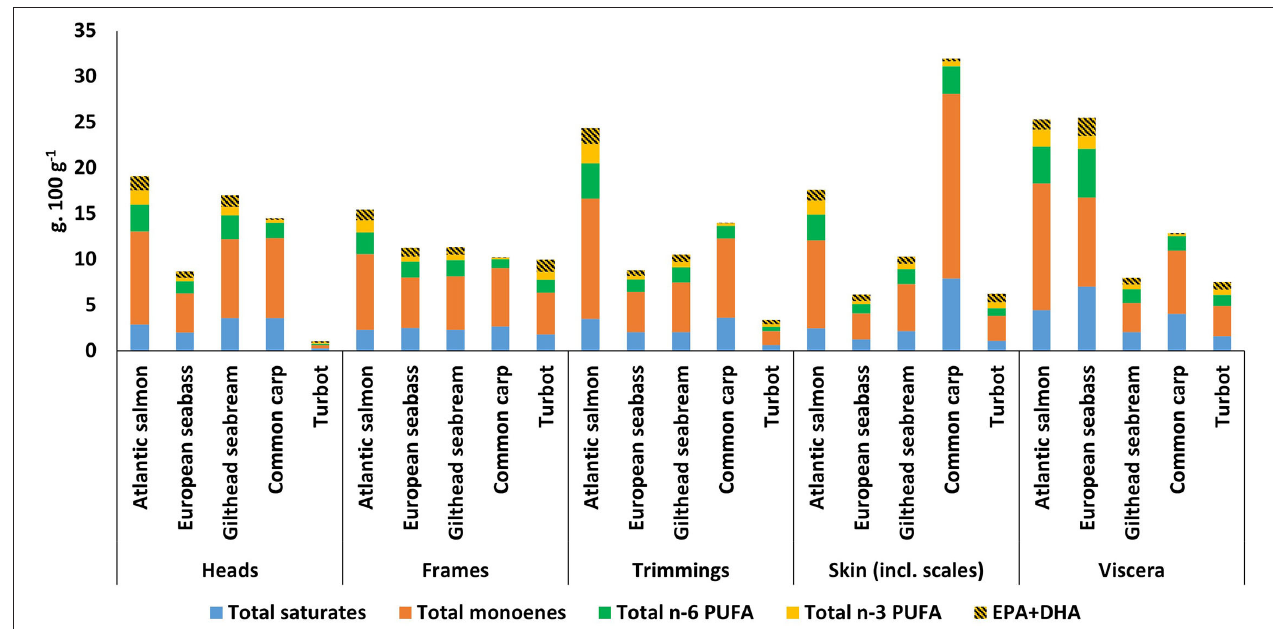
FIGURE 4 | Fatty acid group contents (g.100 g − 1 of wet weight sample) per by-product and per species (excluding 16:2, 16:3, and 16:4). The totals of the fatty acid groups could slightly differ from the total lipids ( Figure 2E ), as means of fatty acid groups were used. The absolute and % of fatty acid group values and standard deviations are available in the Supplementary Information ( Supplementary Tables 1–5